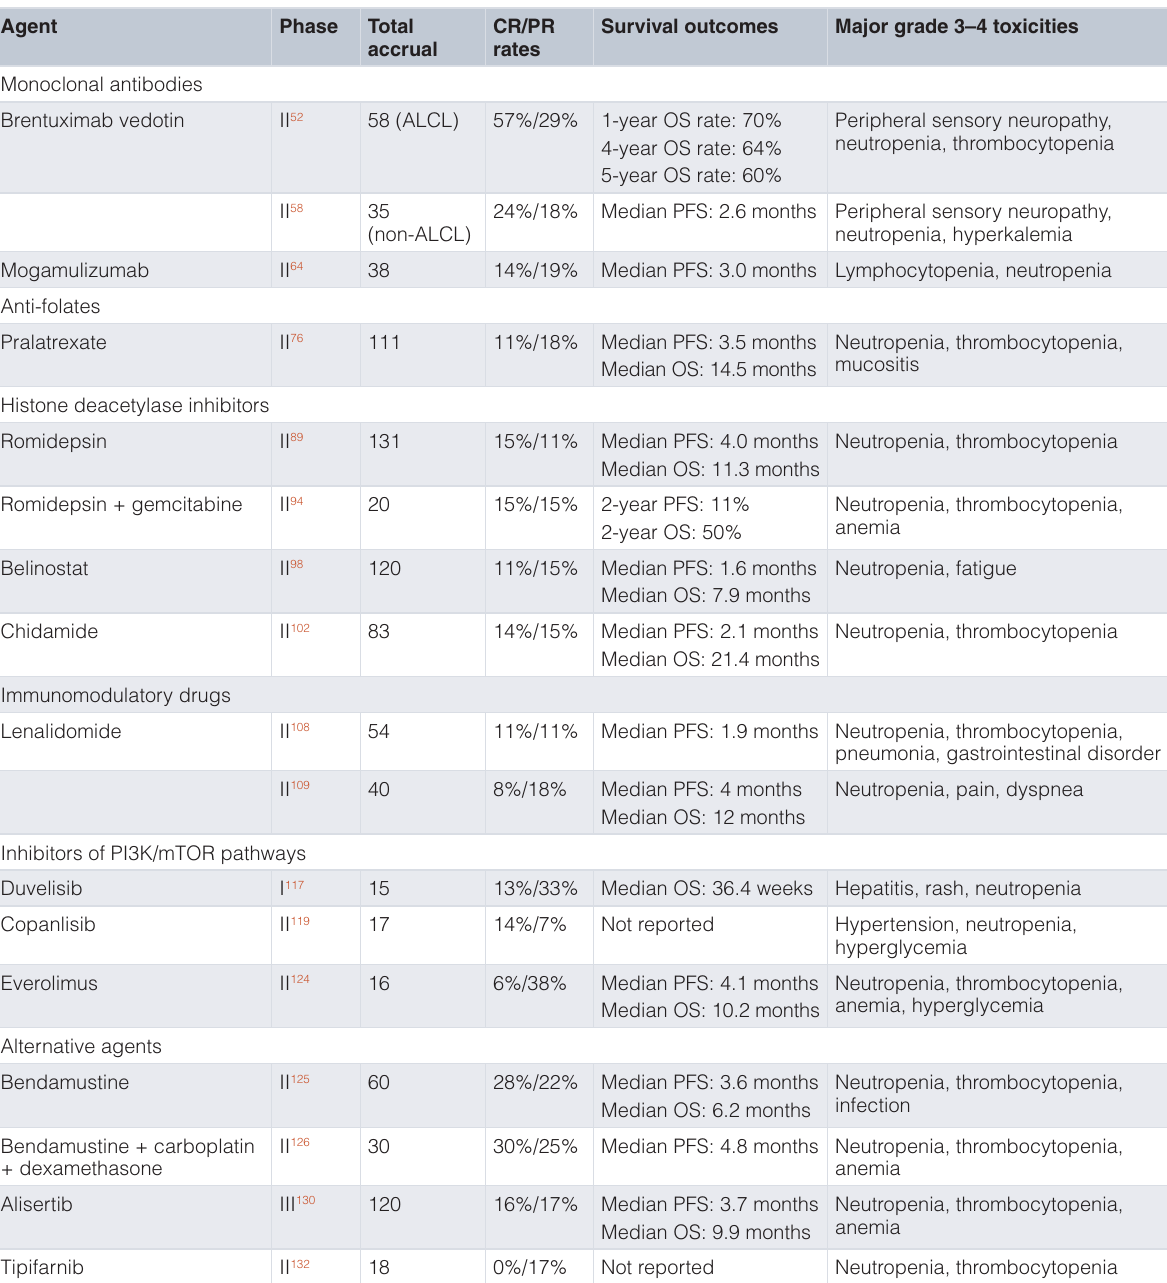
Table 2. Selected studies of novel agents in the treatment of relapsed/refractory peripheral T-cell lymphomas.